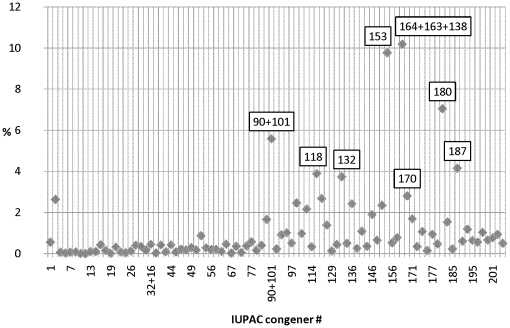
Average PCB congener pattern.The values are expressed as percent of total PCBs. Black rockfish and Pacific halibut were excluded from the calculations.